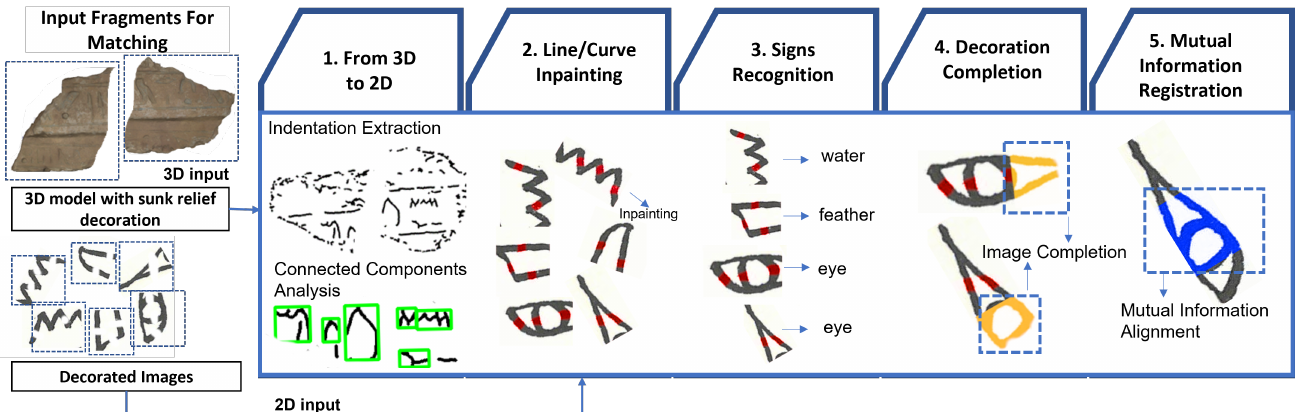
Figure 1. Overview of the proposed registration pipeline based on decoration completeness. The input can be either a 3D model with sunk relief decoration or a monochromatic image. The first step is conducted only when the input is a mesh model. The second and third steps aim to determine the decorated fragments’ completed sign. Finally, the predicted signs are registered by computing their mutual information.